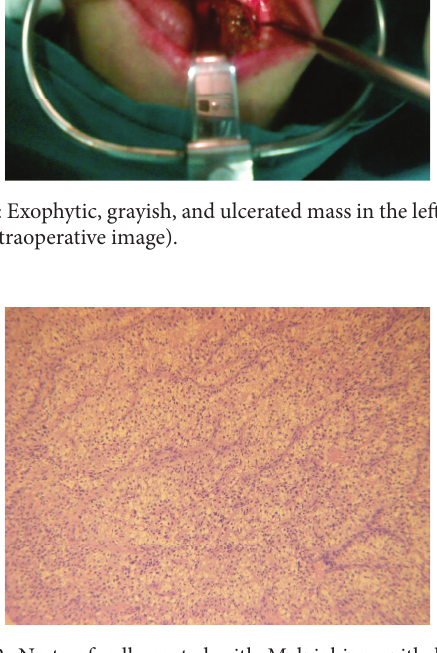
Figure 2: Nests of cells coated with Malpighian epithelium and delimited by fibrous septa. Cells show highly hyperchromatic nuclei and clear cytoplasm (hematoxylin and eosin,